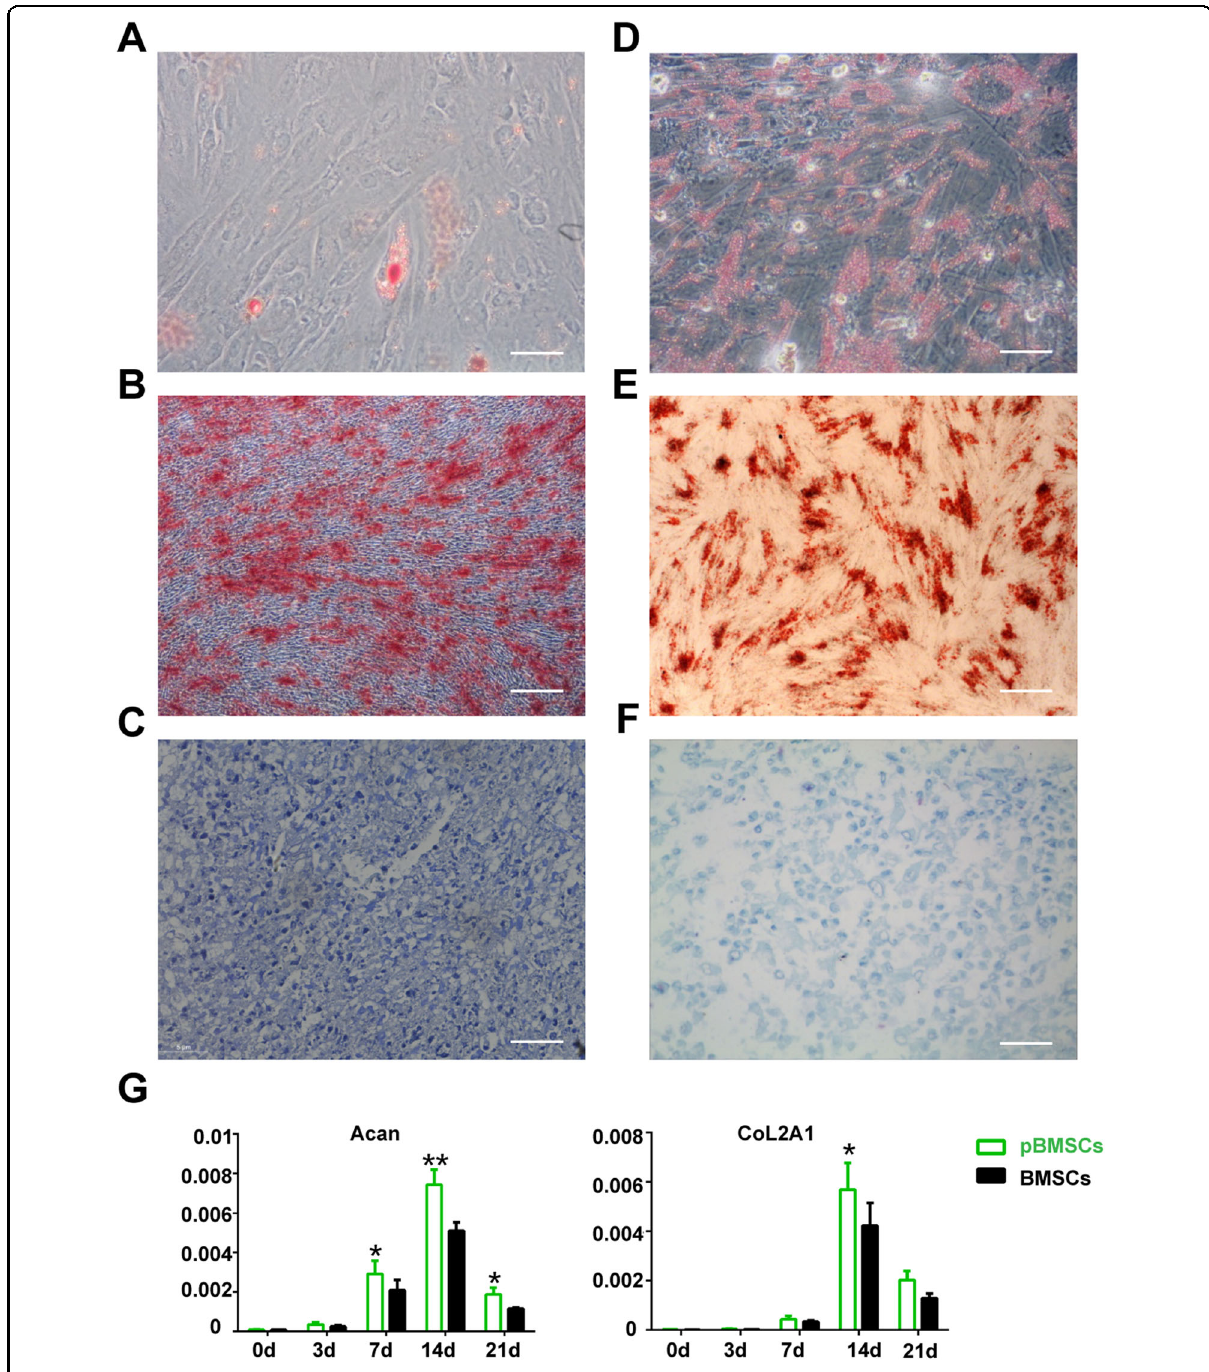
Fig. 2 The potential of the three-dimensional differentiation of the pBMSCs. A – C pBMSCs were puri fi ed from polydactyly bone marrow and then induced into adipose, osteoblast, and chondroblast cells. Scale bars, 40 μ m. D – F BMSCs were puri fi ed from donor bone marrow and then induced into adipose, osteoblast, and chondroblast cells. Scale bars, 40 μ m. G Real-time PCR analysis of Acan and CoL2A1 mRNA expression in the pBMSCs at different time points and BMSCs after induction into chondroblast